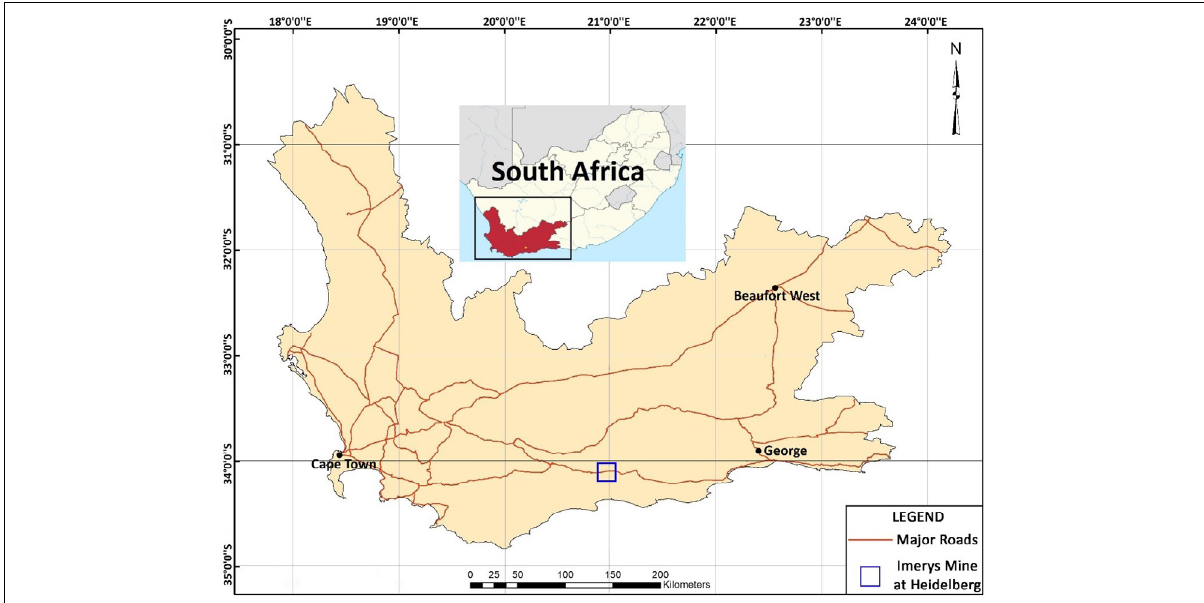
Figure 1: Map of the Western Cape showing the location of the Imerys Mine in